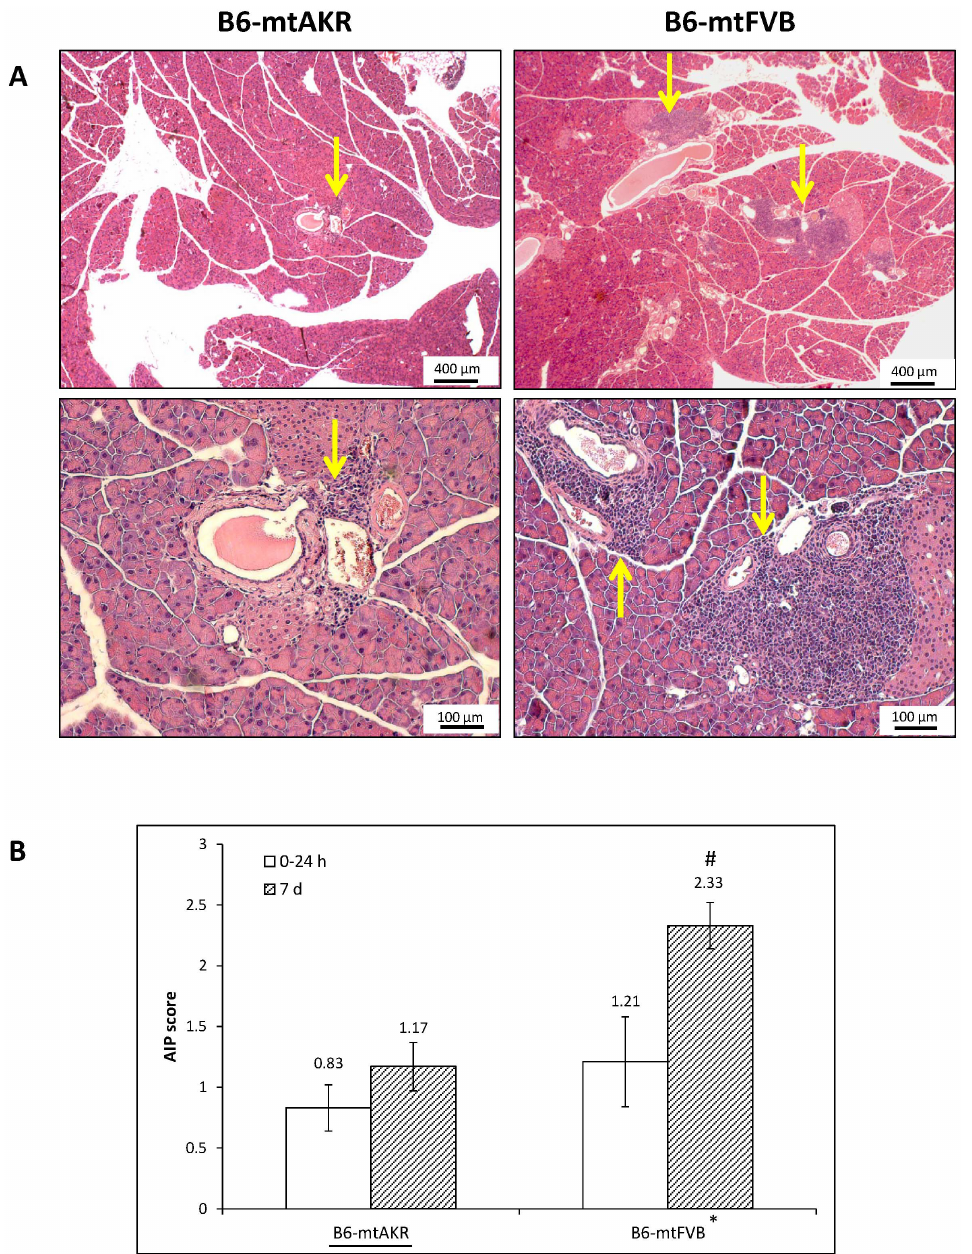
Figure 7. Effects of cerulein on the progression of autoimmune-like pancreatic lesions. Pancreatic sections of untreated and cerulein- treated 12-month-old B6-mtAKR and B6-mtFVB mice were stained with H&E and analyzed regarding the presence of autoimmune-like pancreatic lesions. (A) The microphotographs show typical examples of immune cell infiltrates, indicated by arrows, in B6-mtAKR (left photographs) and B6- mtFVB (right; the photographs show two different stains from the same animal) mice on day 7 after the start of cerulein treatment. (B) For further analysis, the mice of both strains were split into two groups, consisting of ( i ) all animals sacrificed at 0–24 h after the start of cerulein treatment (n=24 per strain) and ( ii ) individuals of the day 7 group (n=6 per strain). The results represent mean values 6 SEM. * P U =0.046 (B6-mtAKR vs. B6- mtFVB mice), # P U =0.021 (0–24 h vs. day 7 mice).